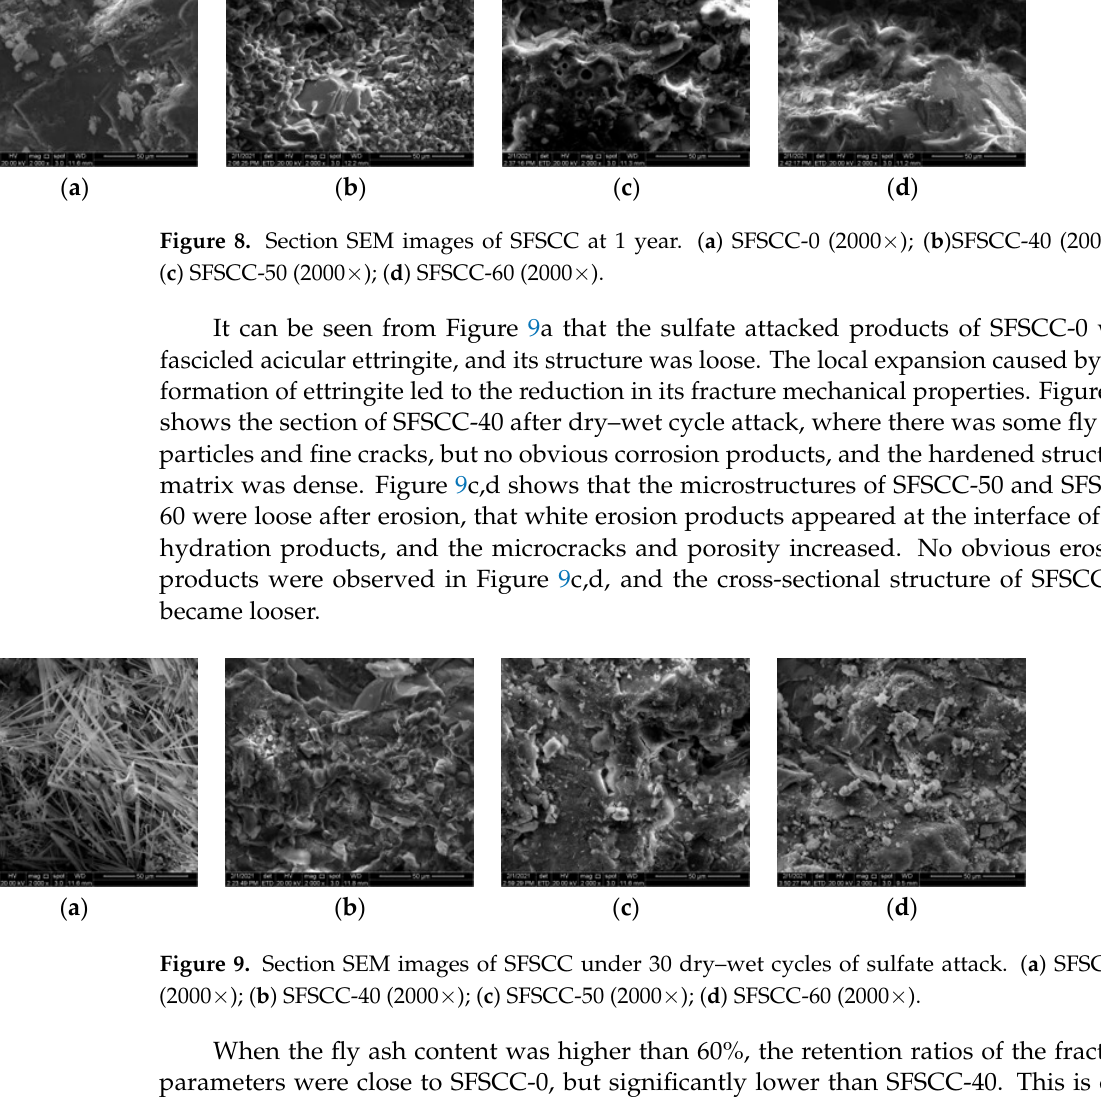
Figure 7. The fracture parameter retention ratio of SFSCC.